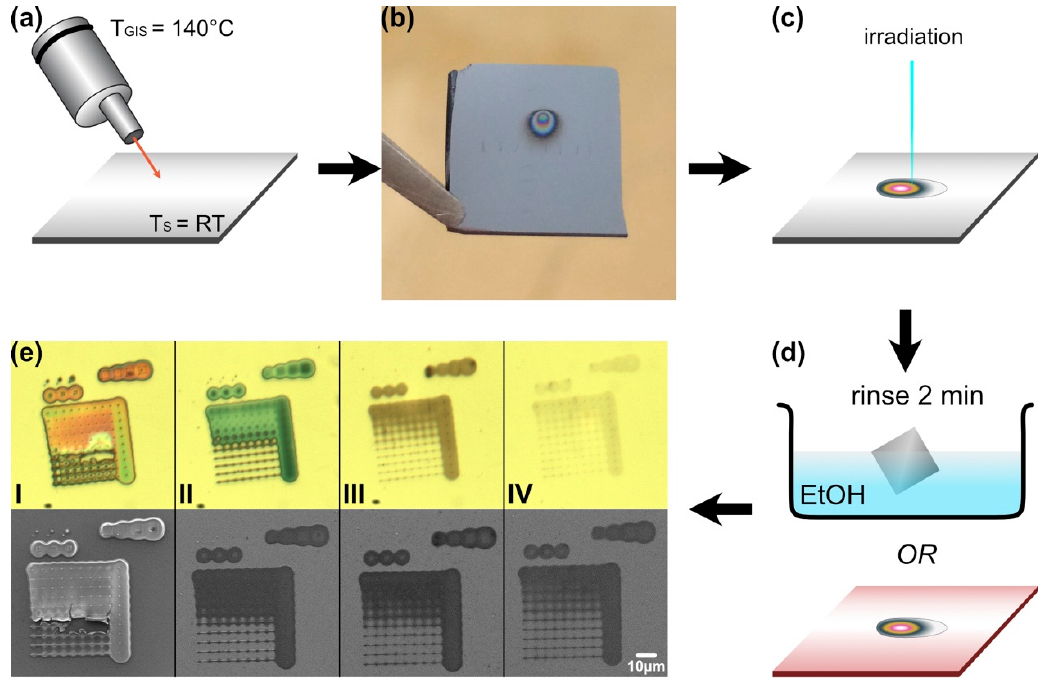
Figure 1. Experimental scheme of direct EBL in a Cu 2 (pfp) 4 resist. ( a ) Precursor evaporation through GIS on a cold substrate. ( b ) Photo of the precursor condensate (“resist”). ( c ) Electron irradiation of the resist. ( d ) Pattern development by rinsing for 2 min in ethanol (EtOH) or heating the substrate for precursor sublimation. ( e ) Optical (upper) and SEM (lower) images of four irradiated structures after development in EtOH. The structures were written in differently thick condensate (gradient: center to outside = thick to thin = I to